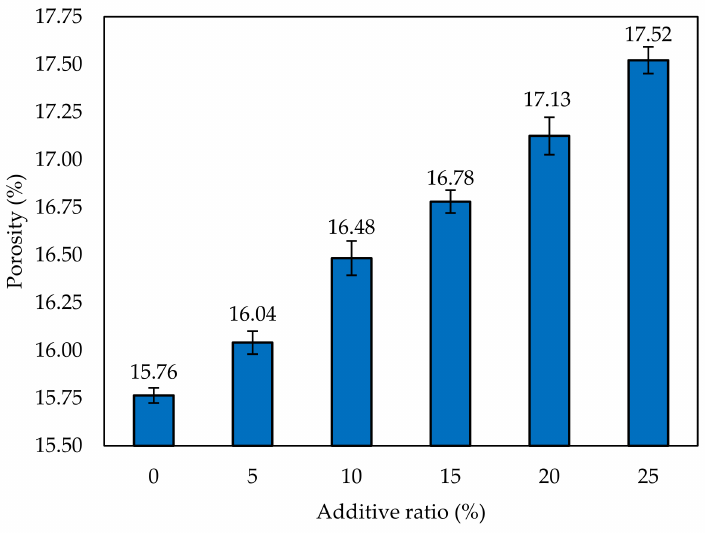
Figure 4. Porosity test results of the cementitious